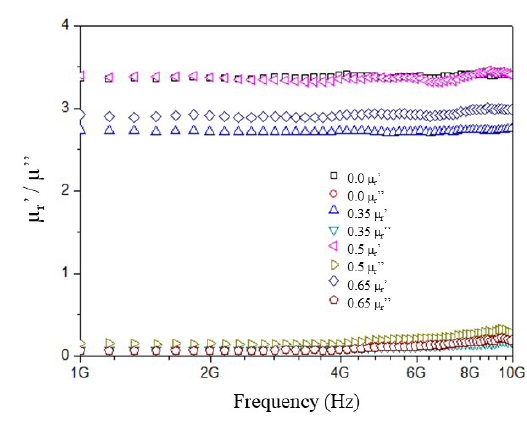
Figure 8. Permeability versus Frequency for the blankets with Mn